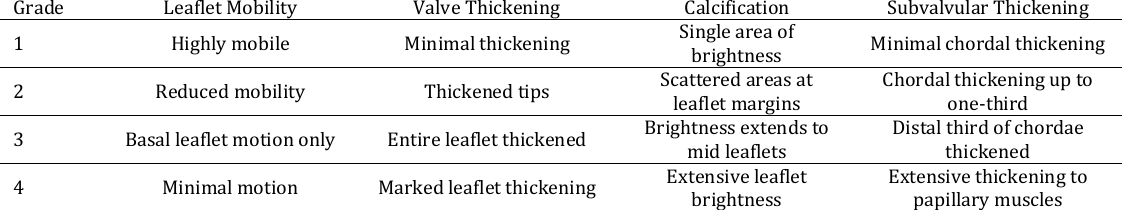
Table1. Wilkins Scoring System for Mitral Valvuloplasty Grade Leaflet